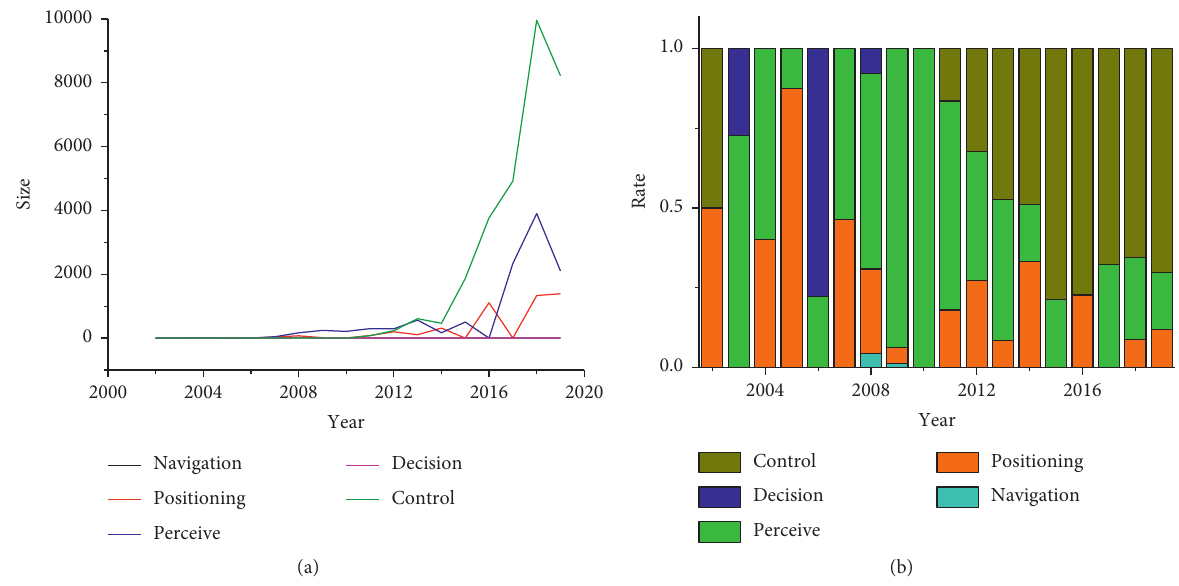
Figure 11: The trend of subdivided topics of “Software” in patents: (a) amount; (b) relative